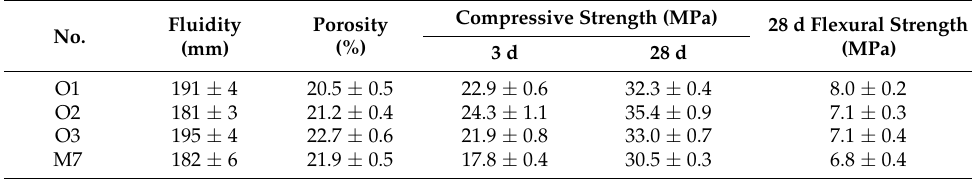
Table 8. Performance index of